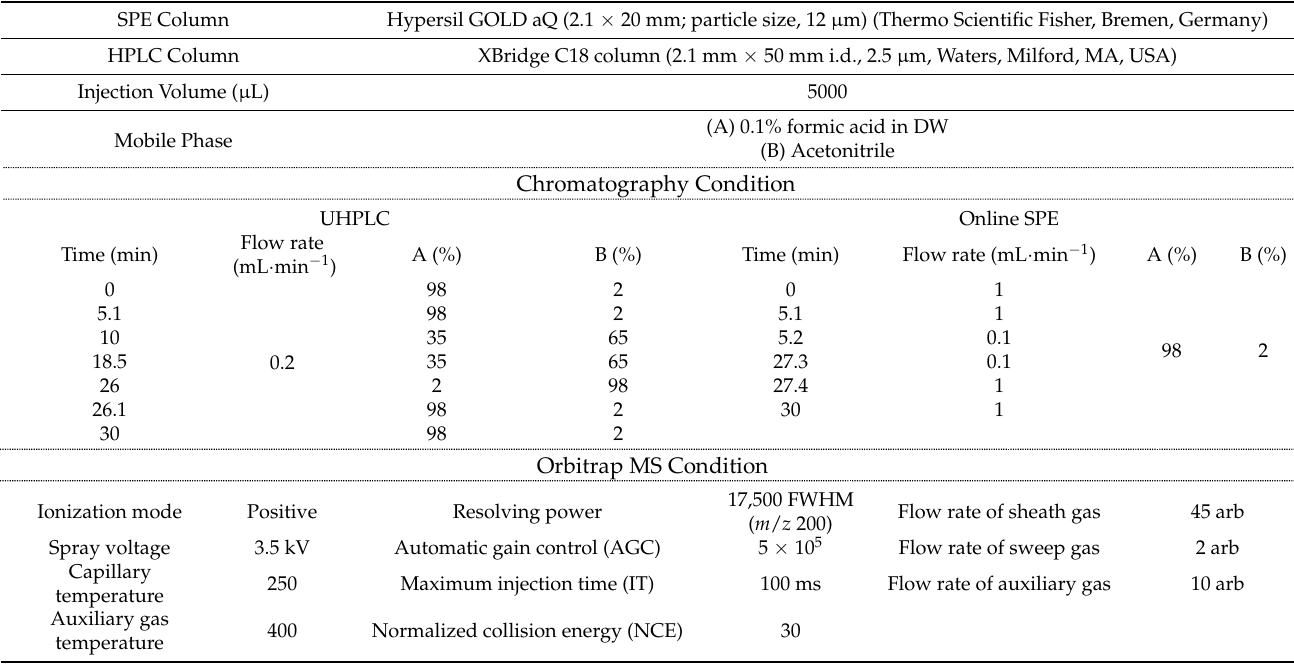
Table A1. Instrument conditions for the selected veterinary antibiotics.